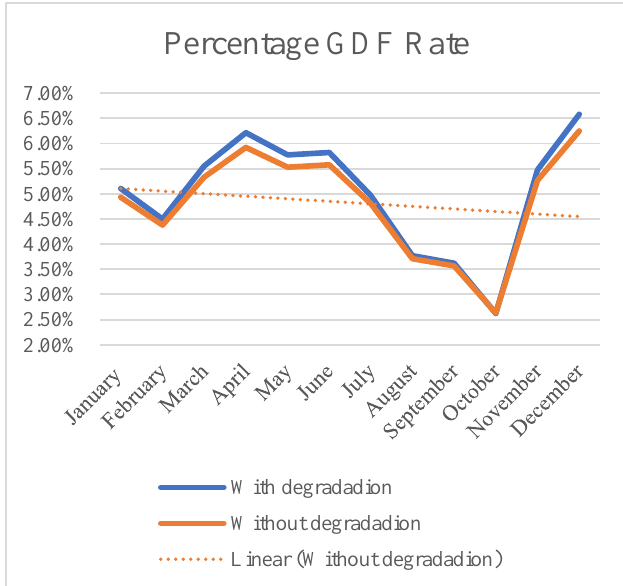
Fig. 12. Percentage GDF rate of QASPP & Crest energy